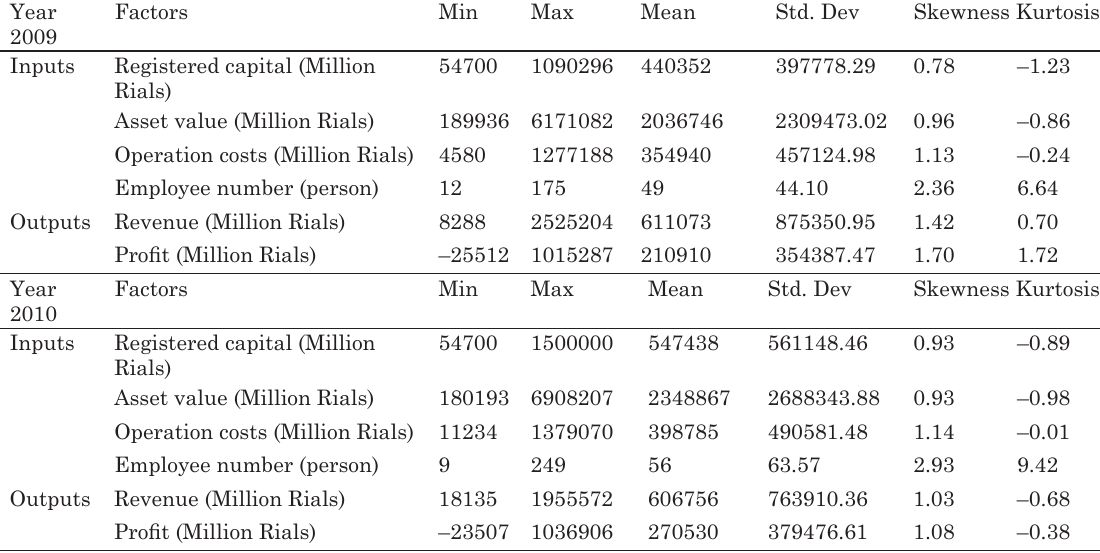
Table 1. Descriptive statistics for the